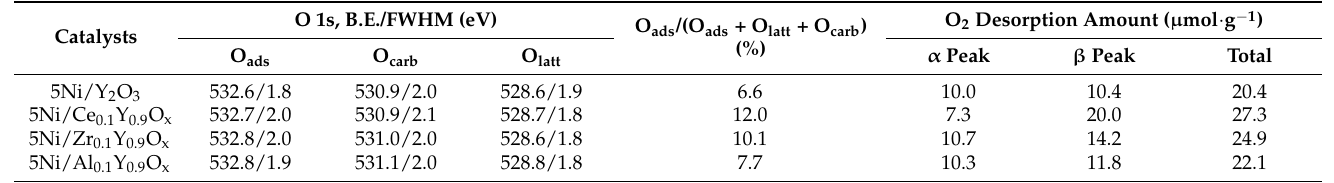
Table 6. Surface oxygen characteristics of the catalysts identified by XPS and O 2